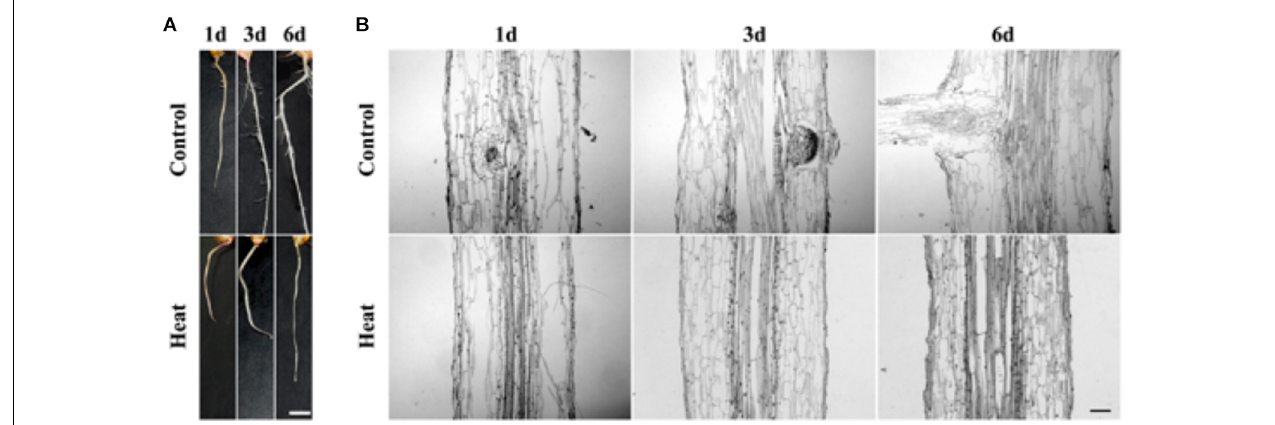
FIGURE 1 | (A) Phenotype characteristics of maize plant at 1, 3, and 6 days under heat treatment and control condition. The lateral root primordium (LRP) initiation was inhibited in maize seedling under heat treatment for 1 day hence no lateral root was observed. Bar = 5 mm. (B) Paraffin section of the LRP zone. Analysis of paraffin tissue section showed that the LRP initiation was inhibited under heat stress. As compared to the untreated controlled root LRP initiation was not observed under heat treatment incubation at 45 ◦ C, suggesting that LRP initiation was inhibited. Bar = 10 µ m.